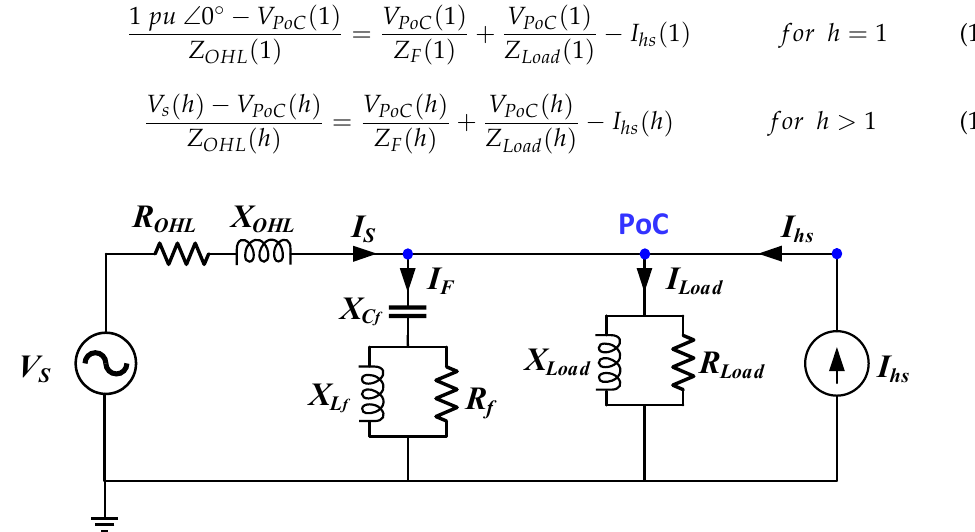
Figure 2. Detailed circuit modeled for harmonics flow analysis for PPF design.